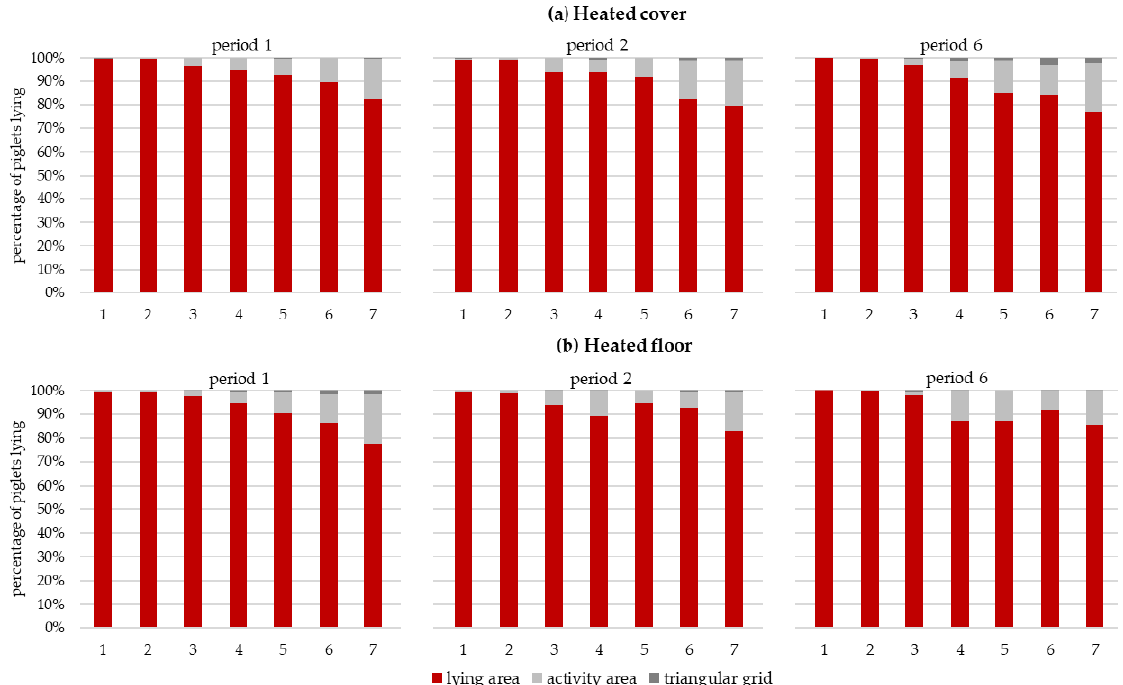
Figure 5. Percentage of piglets (96 piglets per period) lying on the lying area, the activity area, or the triangular grid. ( a ) Data of the three rearing periods with a heated cover; ( b ) data of the three rearing periods with a heated floor. There were usually n = 124 scan-sampling observations for each of the six graphs.